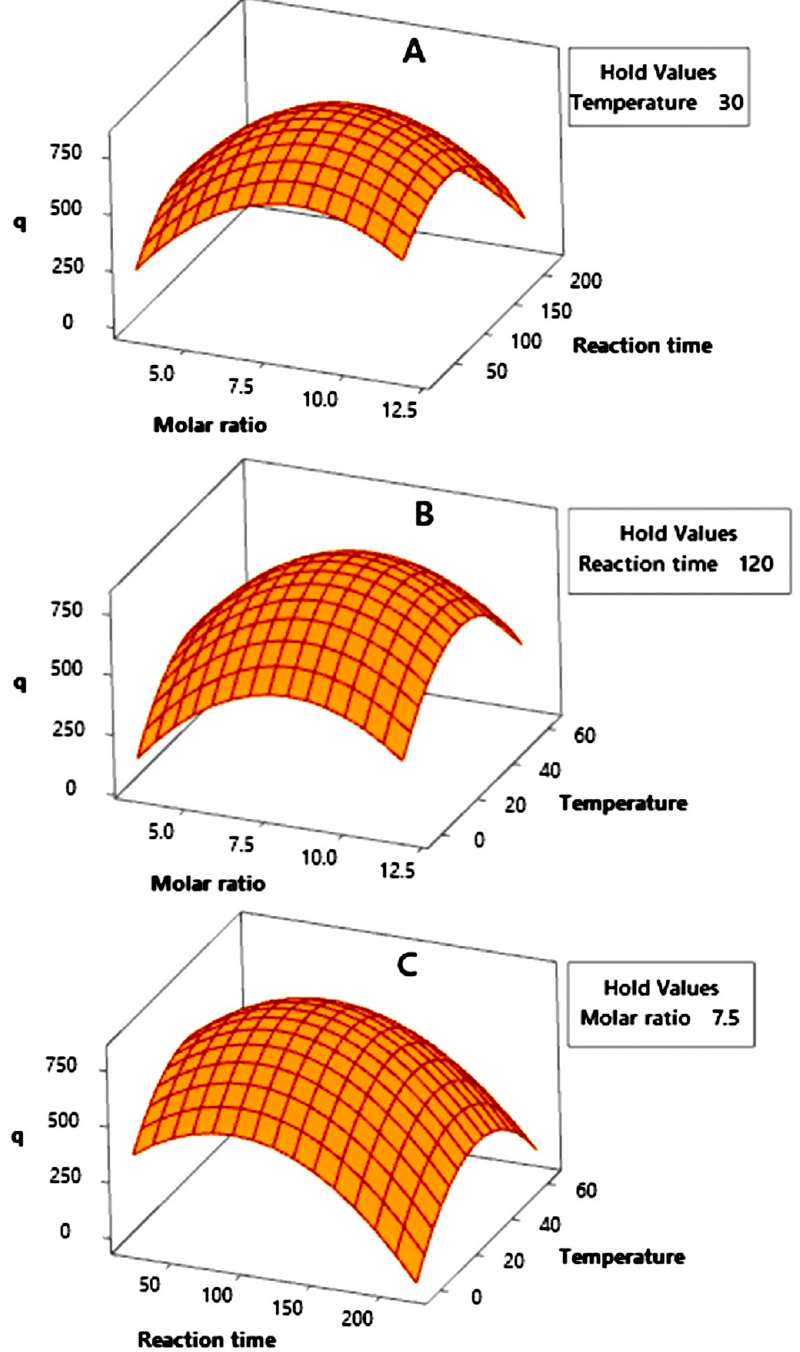
Figure 5. 3D surface plots of the interaction effects between ( A ) the molar ratio and the reaction time, ( B ) the molar ratio and the temperature, and ( C ) the reaction time and the temperature on the synthesis of ZIF-L, as measured by the 𝑞